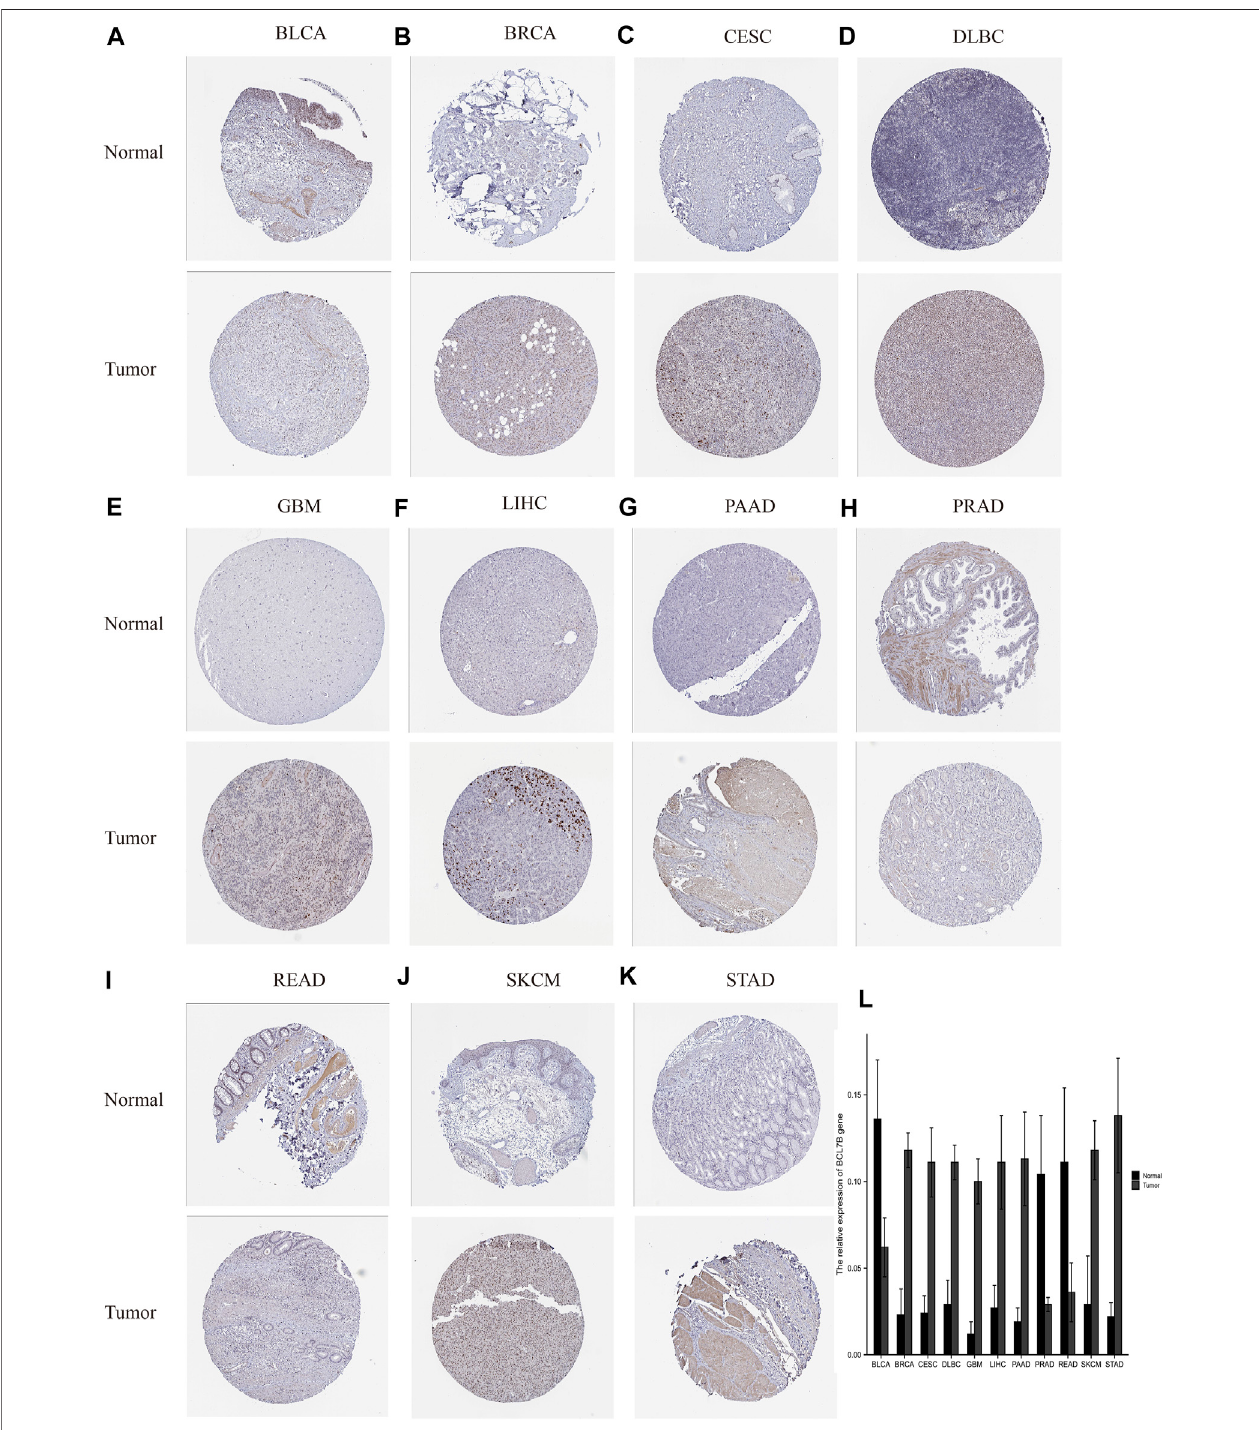
FIGURE 8 | Veri fi cation of BCL7B gene expression in tumors and corresponding normal tissues based on the HPA database. At the protein level, BCL7B gene expression was high in tumor tissues in BRCA, CESC, DLBC, GBM, LIHC, PAAD, SKCM, and STAD (B – G, J,K) and low in BLCA, PRAD, and READ (A,H,I) . (L) Quantitative expression of BCL7B gene.